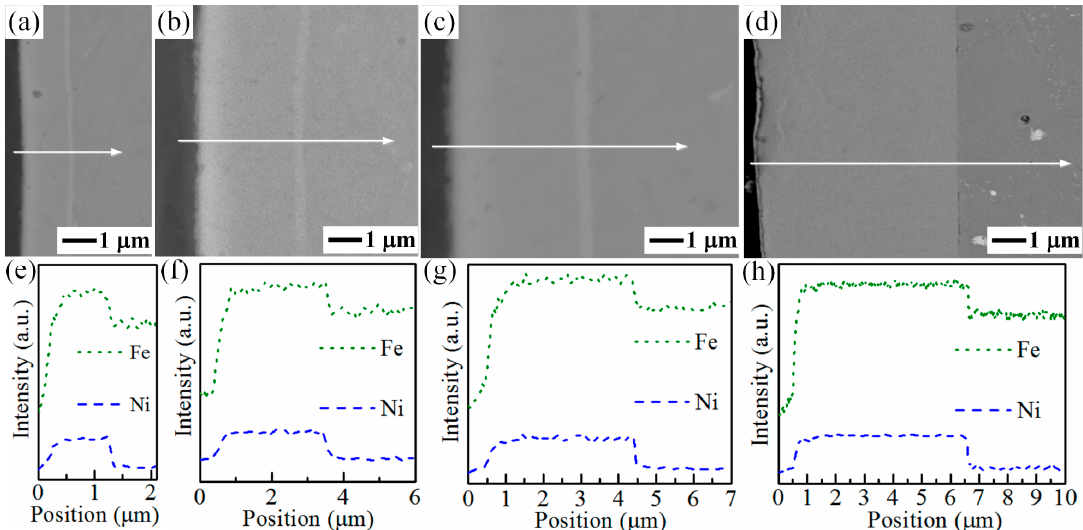
Figure 2. Scanning electron microscopy (SEM) images of cross-section of the samples coated with Fe–Ni films of various thickness: ( a ) 1.4 μ m, ( b ) 2.4 μ m, ( c ) 3.8 μ m, and ( d ) 6.0 μ m; corresponding energy dispersive X-ray analyzer (EDS) line scan results at locations marked on SEM images: ( e ) 1.4 μ m, ( f ) 2.4 μ m, ( g ) 3.8 μ m, and ( h ) 6.0 μ m.